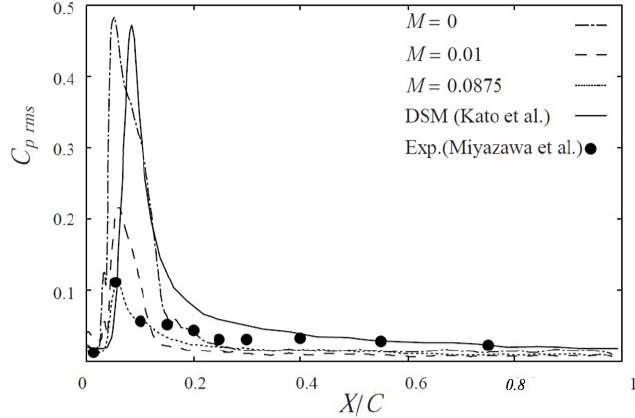
Figure 4. Mean pressure coefficient for cases of Straight-1, -4, and -5 in Table 1.